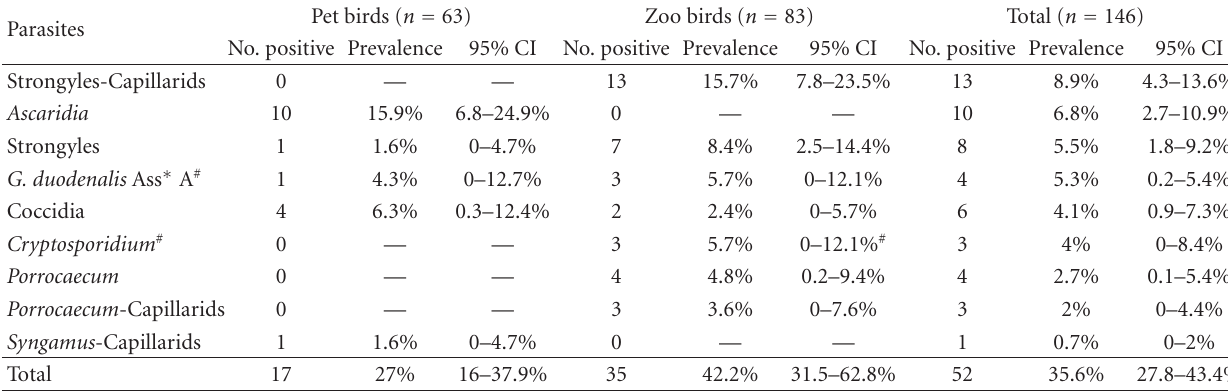
Table 3: Number of positive samples, prevalence, and 95% confidence intervals (95% CI) of intestinal parasites in pet and zoo birds.